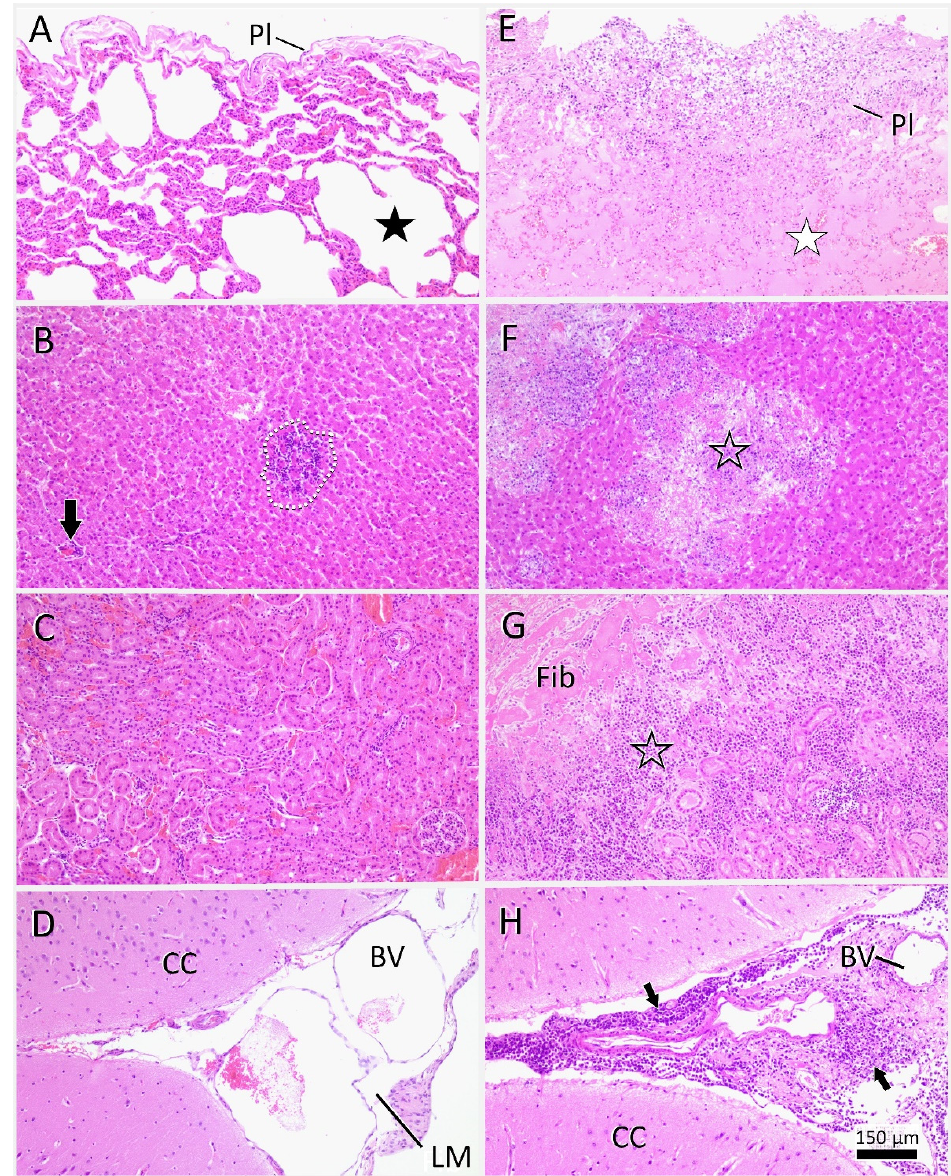
Figure 6. Histology of lungs, liver, kidney, and brain of the cat ( A – D ) as opposed to cats with local feline infectious peritonitis (FIP)-associated changes ( E – H ). Lungs : Note, that the fatally injured cat presented with an alveolar emphysema ( A : black asterisk), while FIP-typical pleural changes ( E : Pl) and proteinaceous alveolar oedema ( E : white asterisk) were not observed. Liver : The cat showed further signs of mild lymphocytic periportal hepatitis ( B : black arrow), and multifocal necrotizing hepatitis ( B : dashed line). Once again, fibrinoid and pyogranulomatous liver changes in cats with FIP ( F: empty asterisk) were not evident. Kidneys : In the kidneys a mild congestion was seen ( C ). In FIP ( G ), fibrin ( G : Fib) and pyogranulomatous changes ( G : empty asterisk) can extend from the capsule into the depth of renal parenchyma with effacement of cortical architecture. Brain : Apart from the peracute medullospinal tear, the central nervous system (CNS) condition was unremarkable ( D ), including FIP predilection sites of the leptomeninges ( D : LM)and brain ventricles (not shown). In CNS manifestation of FIP ( H ), there were mostly ill-defined fibrinonecrotic and pyogranulomatous changes in the meninges intermingling with extensive lymphoid infiltrates ( H : arrows). Markers: BV, blood vessels; CC, cerebral cortex; LM, leptomeninx; Pl, pleura. Stain ( A – H ): hematoxylin–eosin. Scale bar applies to all photomicrographs.